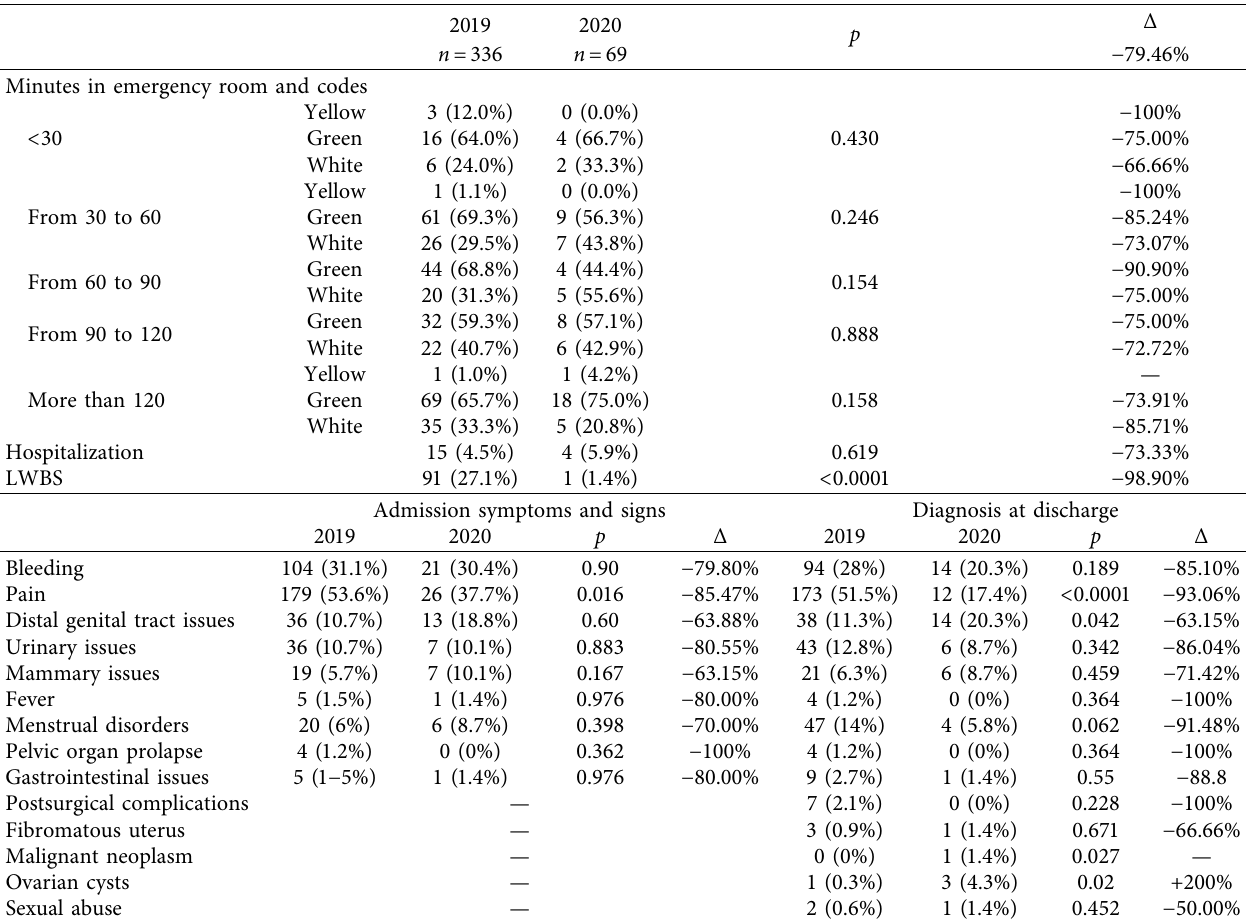
Table 7: Gynecological patients’ characteristics.